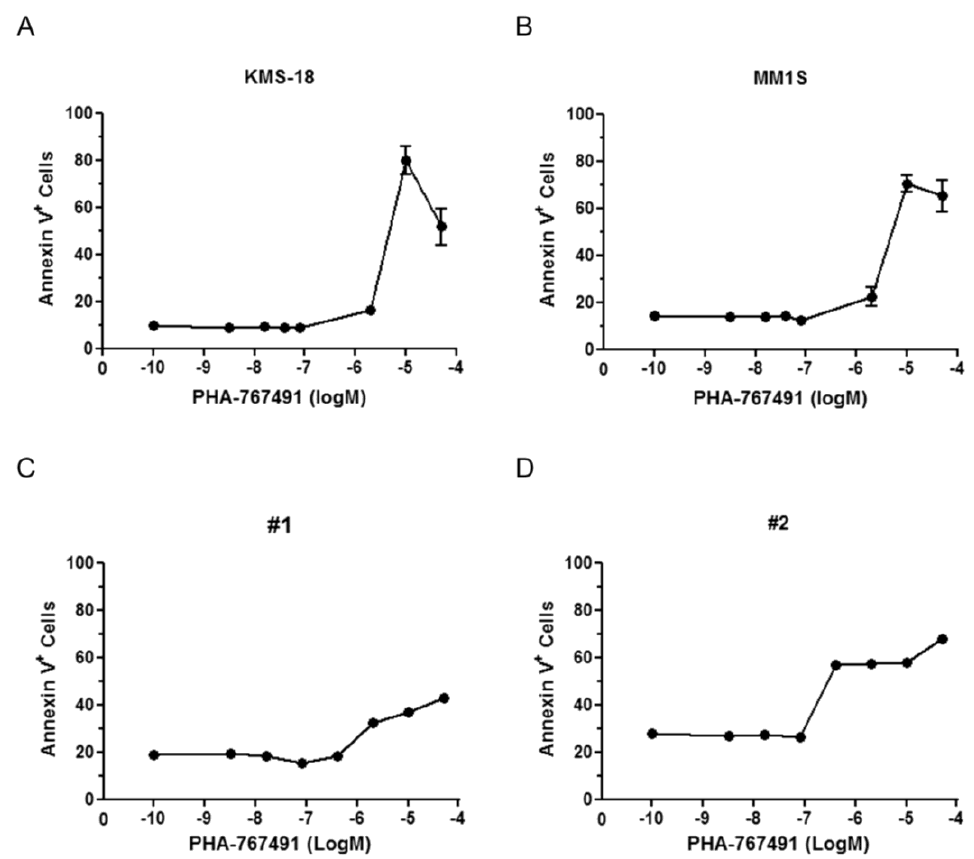
Figure 1. Anti-myeloma activity of PHA-767491. KMS-18 ( A ) and MM1S ( B ) were treated with different doses of PHA-767491 for 24 h and apoptosis was analysed by flow cytometry using AV staining. Data are presented as mean ± standard deviation of two independent repeats; ( C , D ) Purified mononuclear cells from two healthy donors were treated with different doses of PHA-767491 for 24 h and apoptosis was analysed by flow cytometry using AV staining. The M in the x axes defines Molarity.